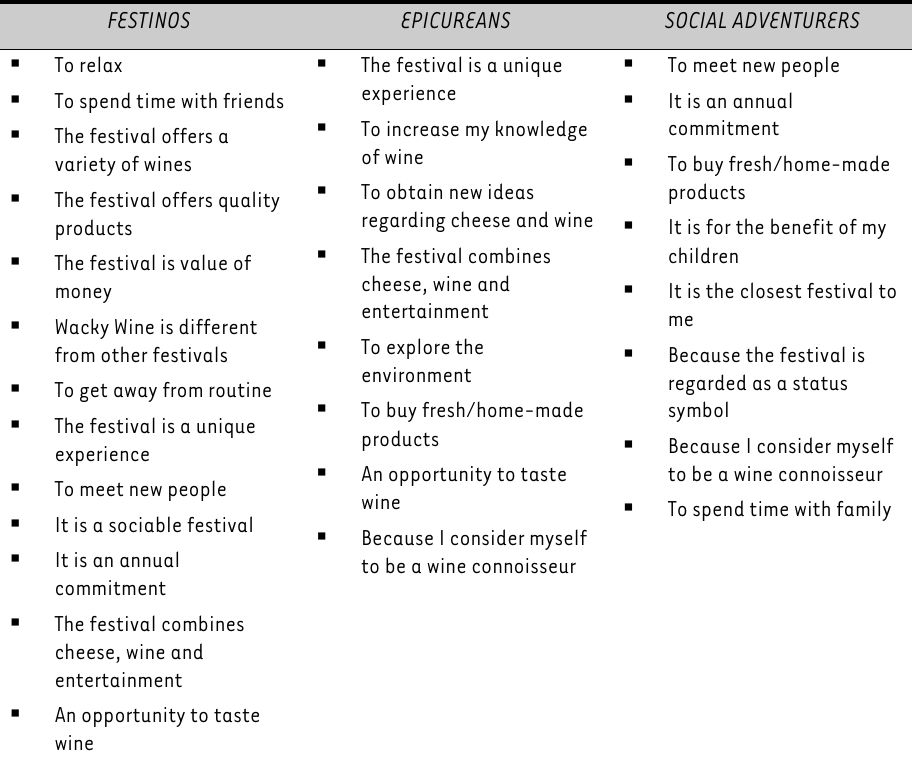
TABLE 1: Types of festival visitors by motivation FESTINOS